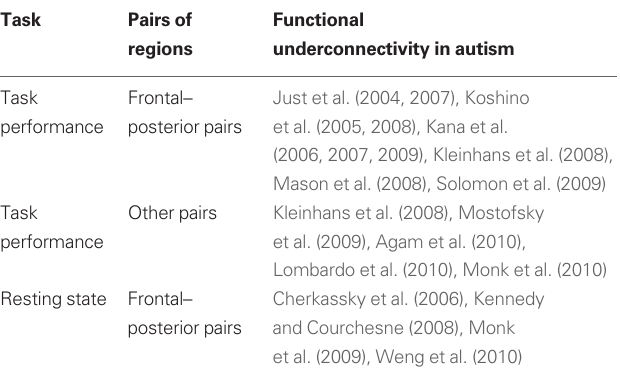
Table 1 | Summary of fMRI functional connectivity